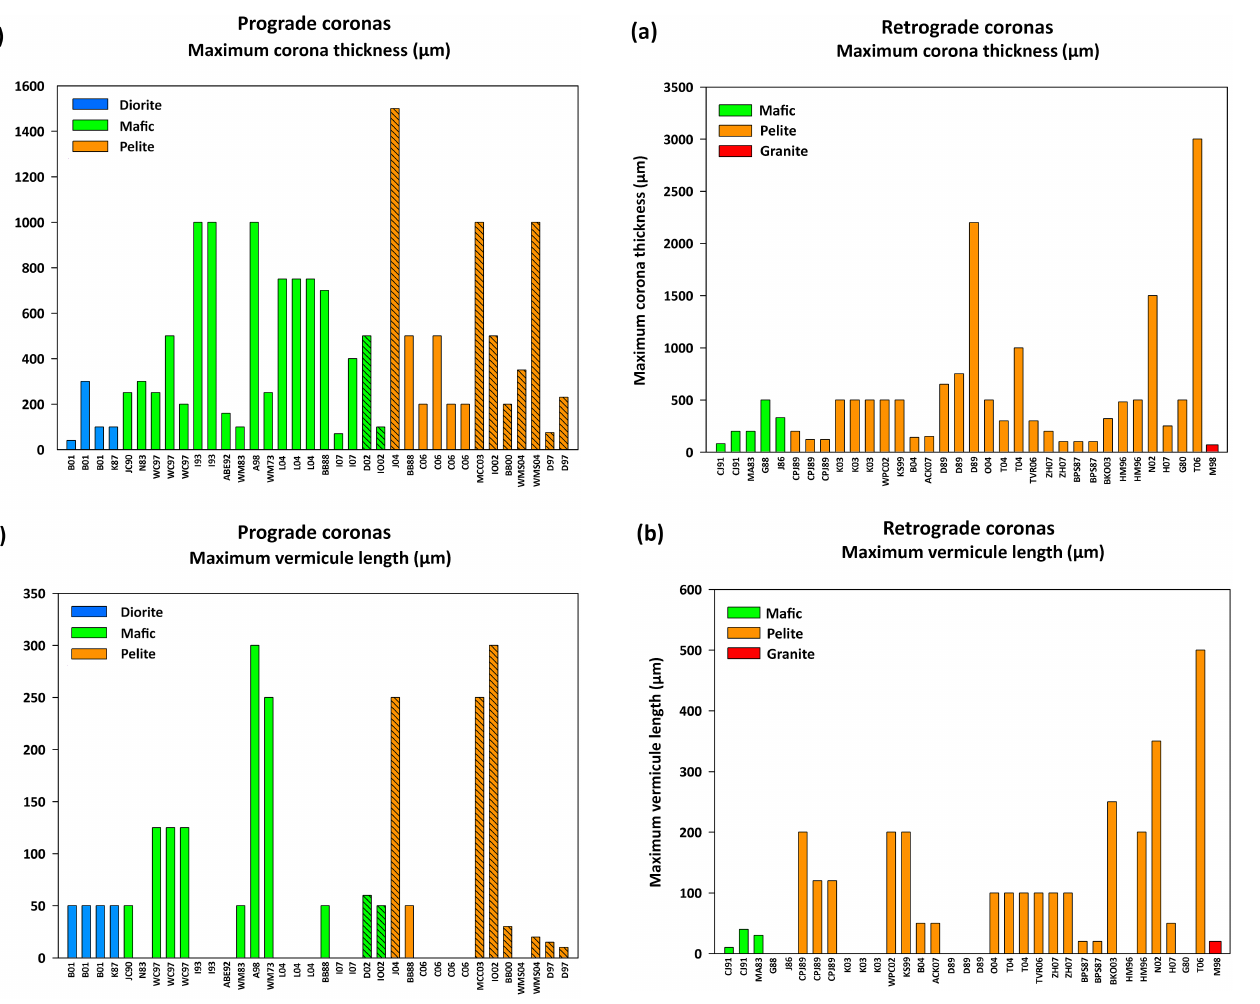
Figure 10. Variation in prograde corona microstructure in mafic and pelitic bulk rock compositions. (a) Variation in maximum corona thickness in prograde coronas. (b) Variation in maximum vermicule length in prograde coronas. Hatched bars are prograde coronas from contact aureoles. Each corona reference is tagged by a code (e.g. WM73) which correlates with the detailed characteristics of each corona in the Tables included in Appendix A.